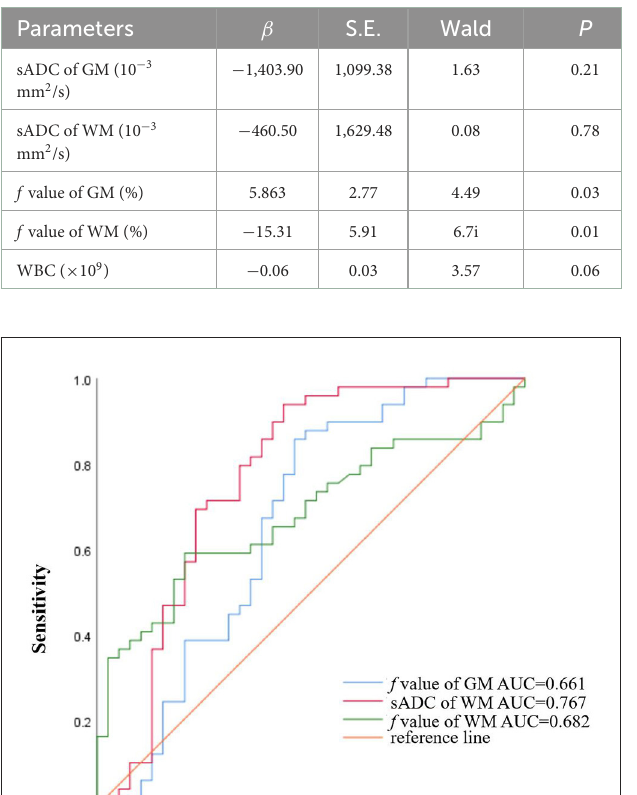
TABLE 2 Multivariate (logistic regression) analyses in healthy participants and patients with AL.